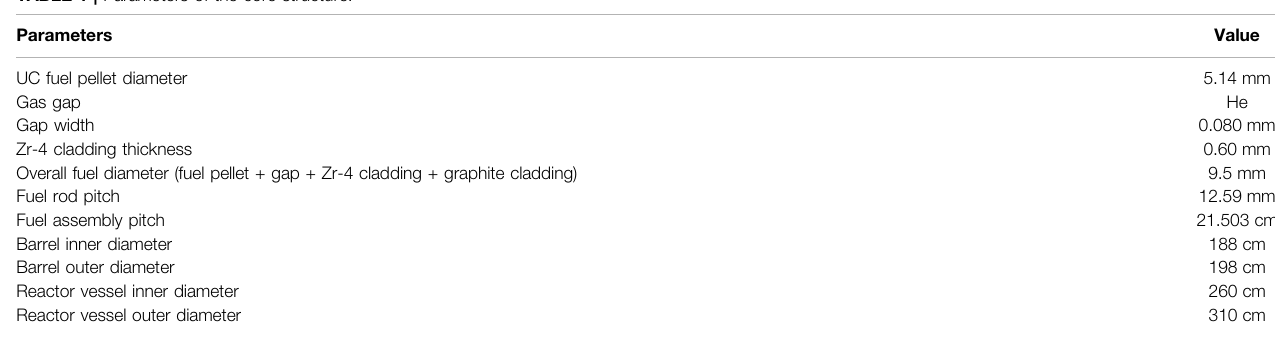
TABLE 1 | Parameters of the core